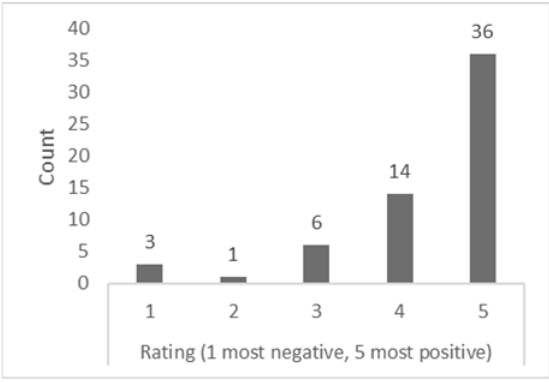
Figure 4 . Count of combined negative and positive responses to the 12 UES-SF questions (Table 2) on attractiveness, aesthetic appeal, visual complexity, adherence, reuse, the influence of the website experience on their decisions to visit the region.